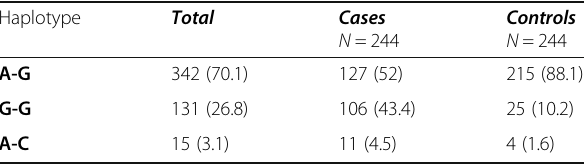
Table 4 Detailed haplotypes frequencies of the LEPR c.668 A > G and LEPR c.1968G>C variants in the pre-eclamptic patients and